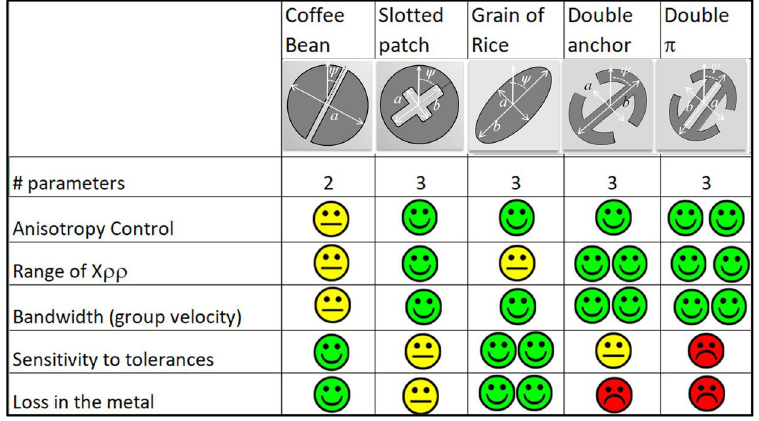
Figure 3. Texture elements features. Summary table with the most relevant electromagnetic performances of the main kinds of textures employed in the synthesis of MTS